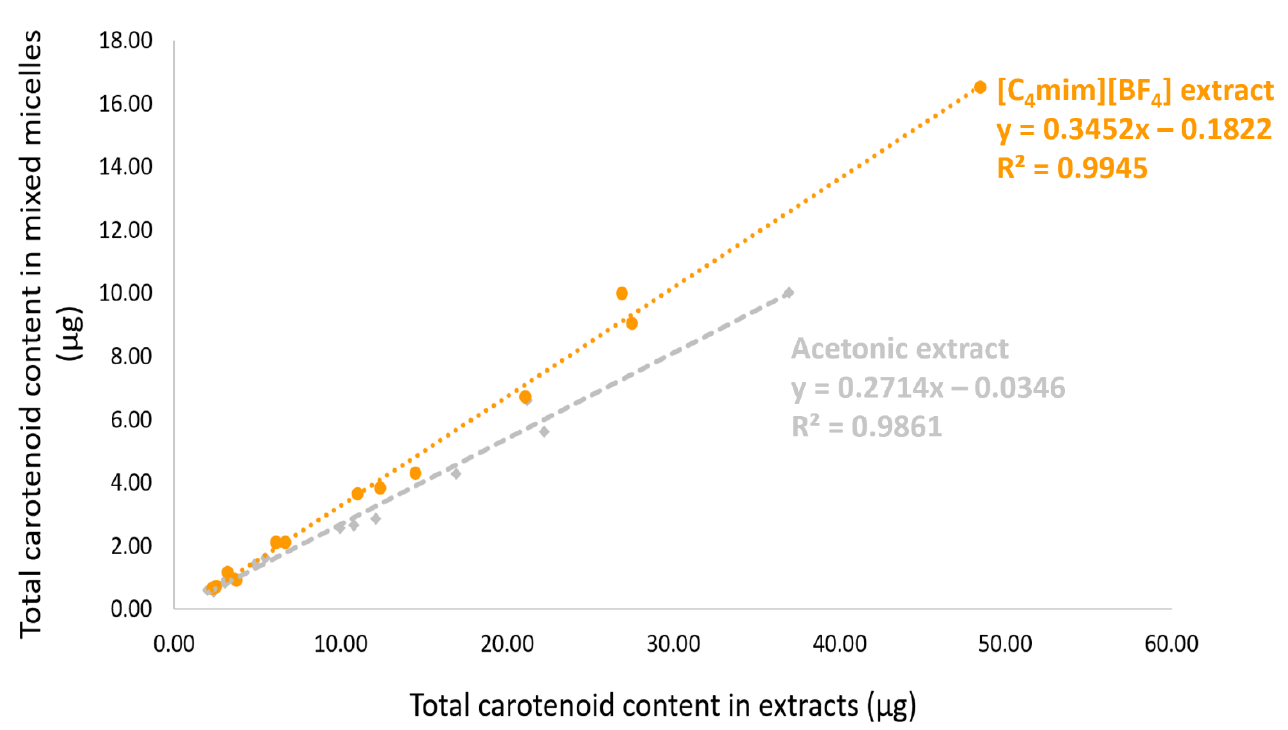
Figure 5. The total carotenoid content in the micelles of the digested samples correlated with the total carotenoid content of the initial samples. Data were analyzed by Pearson’s correlation. Orange points: [C 4 mim][BF 4 ] extract; gray points: acetone extract.